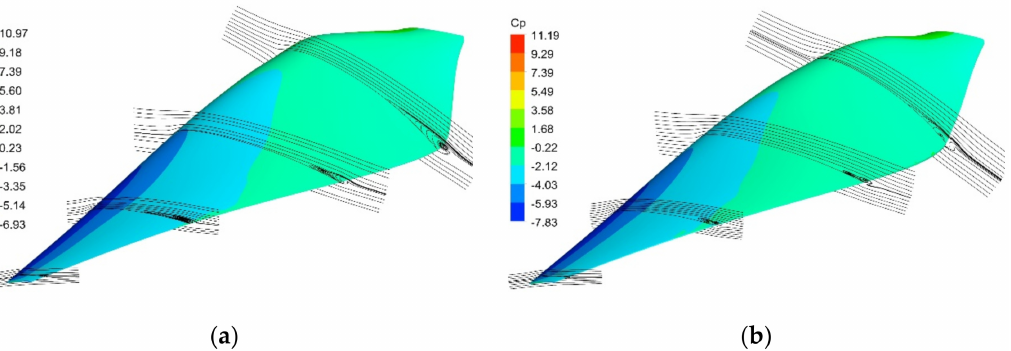
Figure 36. Pressure coefficient distribution and streamlines on different cross-sections of two pro- pellers at State 1: ( a ) Prop A; ( b ) Prop